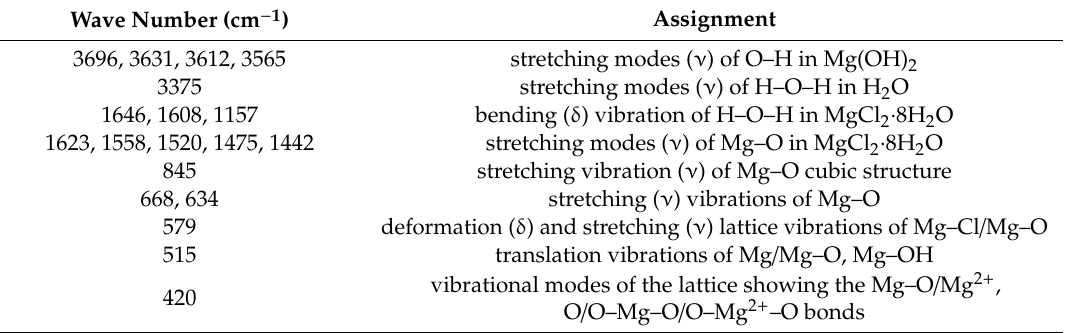
Figure 6. The Fourier-transform infrared (FT-IR) spectrum of MOC 5-1-8 phase in the range of 400–4000 cm − 1 . Table 1. Assignments of the major absorption bands of MOC 5-1-8 phase—reference